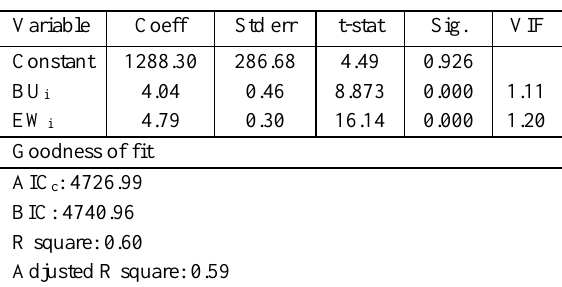
Table 3. Results of Global OLS for trip production